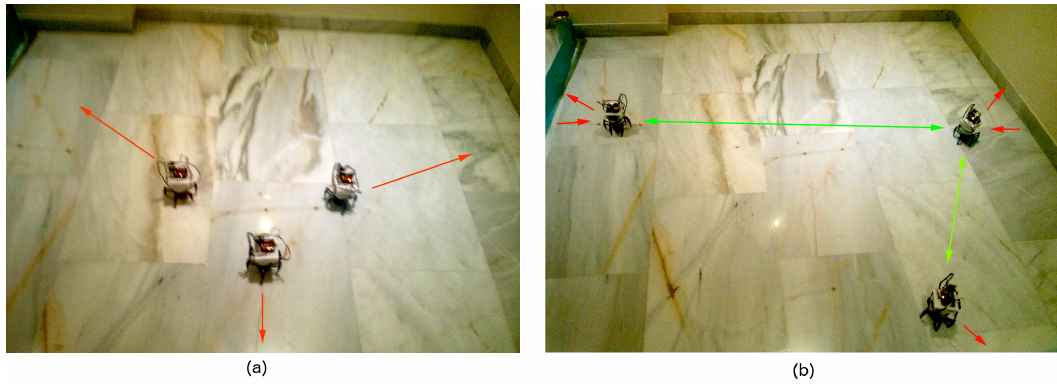
Figure 11. Deployment for three robots in a real environment using SPF: ( a ) initial configuration; ( b ) final configuration.